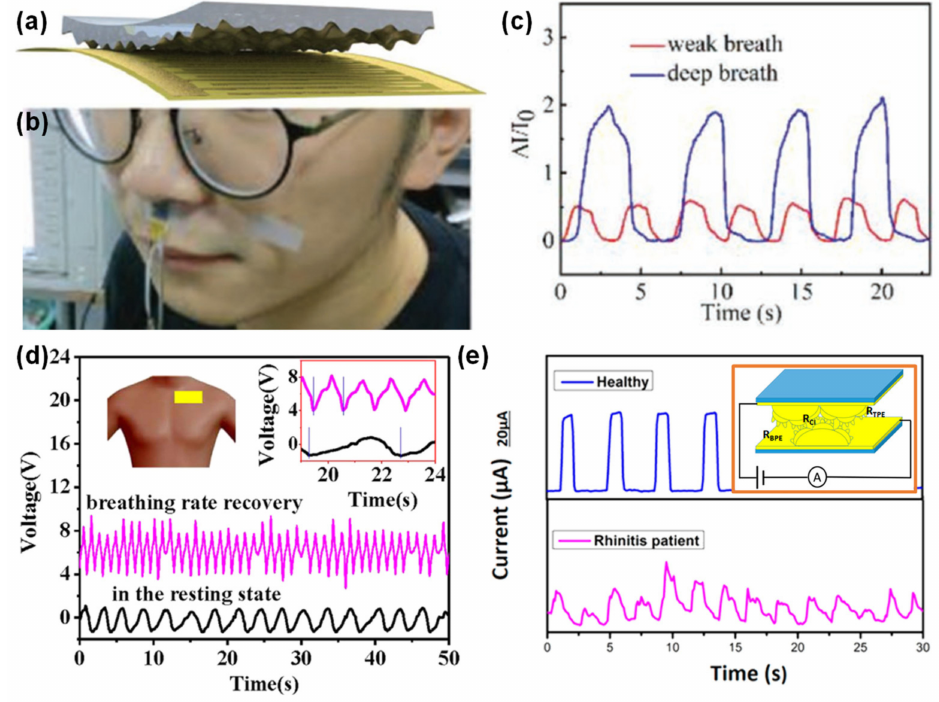
Figure 13. E-skins applied to respiration. ( a ) E-skin developed by Dawen Zeng and co-workers